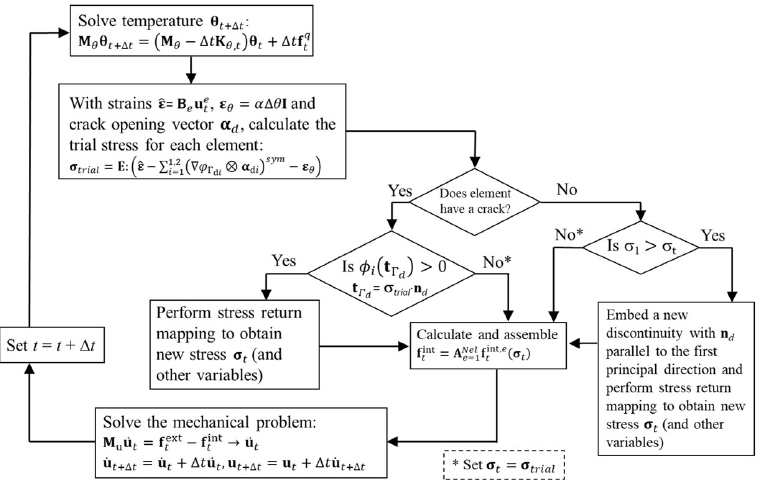
Figure 2. The flow of the global solution process of the thermo-mechanical problem.